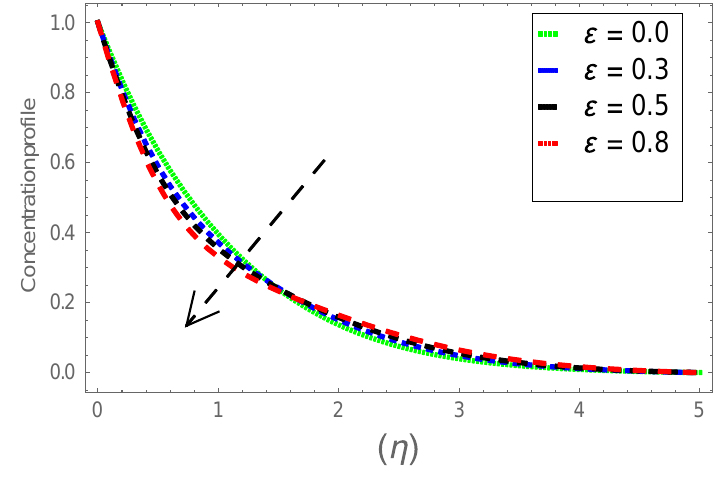
Coatings 2021 , 11 , x FOR PEER REVIEW